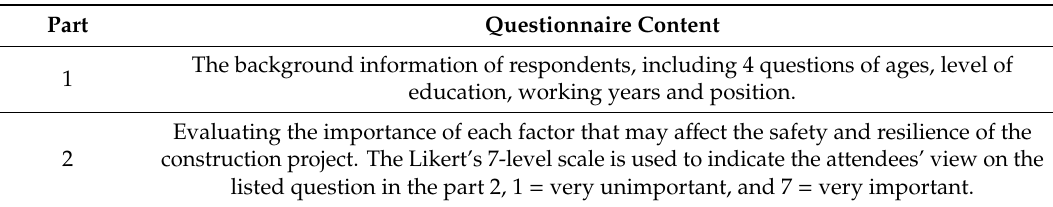
Table 2. The content of the